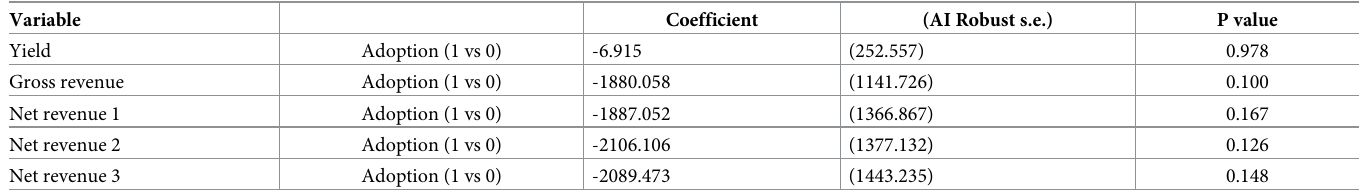
Total number of observations for yield analysis is 809 fields in the 2017/2018 Dong Xuan season, whereas for revenue analysis the number of observations is only 766 due to an unobserved selling price of rice in the case of all rice consumed by